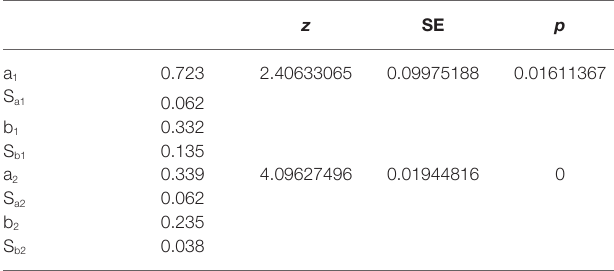
TABLE 5 | Sobel test results (model